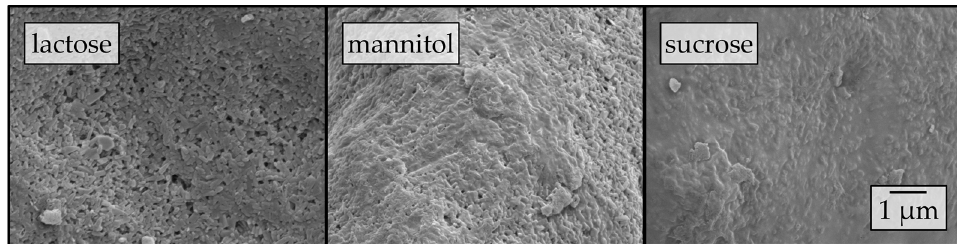
Figure 3. Surface morphologies of granules produced with a naproxen nanosuspension (stabilized with PVP/VA) without additional drying excipients and lactose, mannitol, and sucrose as carrier materials in a fluidized granulation approach, assessed by SEM.